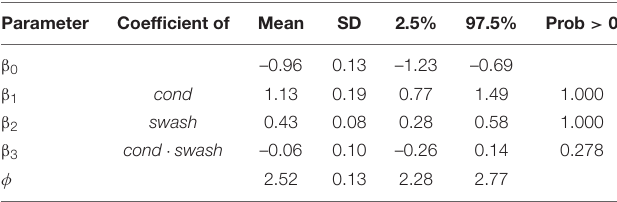
TABLE 4 | Summaries of the posterior distributions of the model (Eqs. 5, 6) showing the means, standard deviations, and 95% credible intervals. Parameter Coefficient